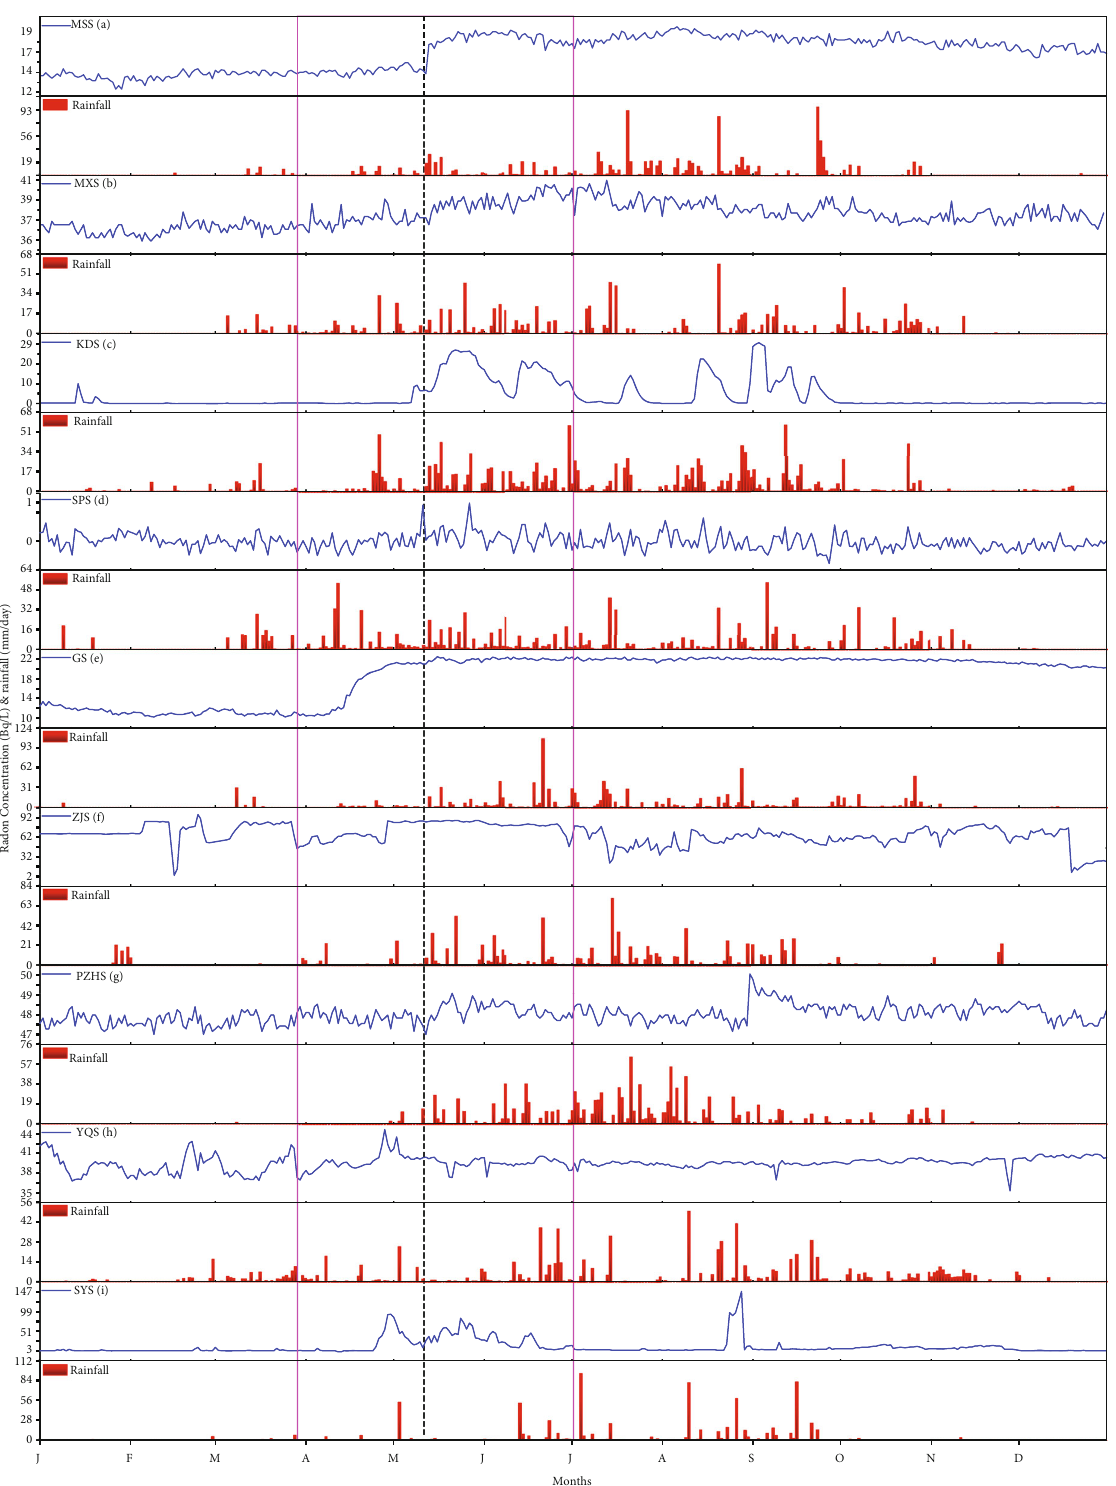
Figure 3: Temporal variation of groundwater Rn recorded at di ff erent stations in the proximity of the Wenchuan earthquake. A time window of 3 months (April-June 2008) is selected for detailed analysis of the Rn variability in connection with this particular earthquake (highlighted by a magenta colour dashed line column). It includes 9 stations in total with 7 stations located near the event epicentre and 2 stations located at distant locations (YQS and SYS stations in Table 1). The black dotted line is the time of the Wenchuan